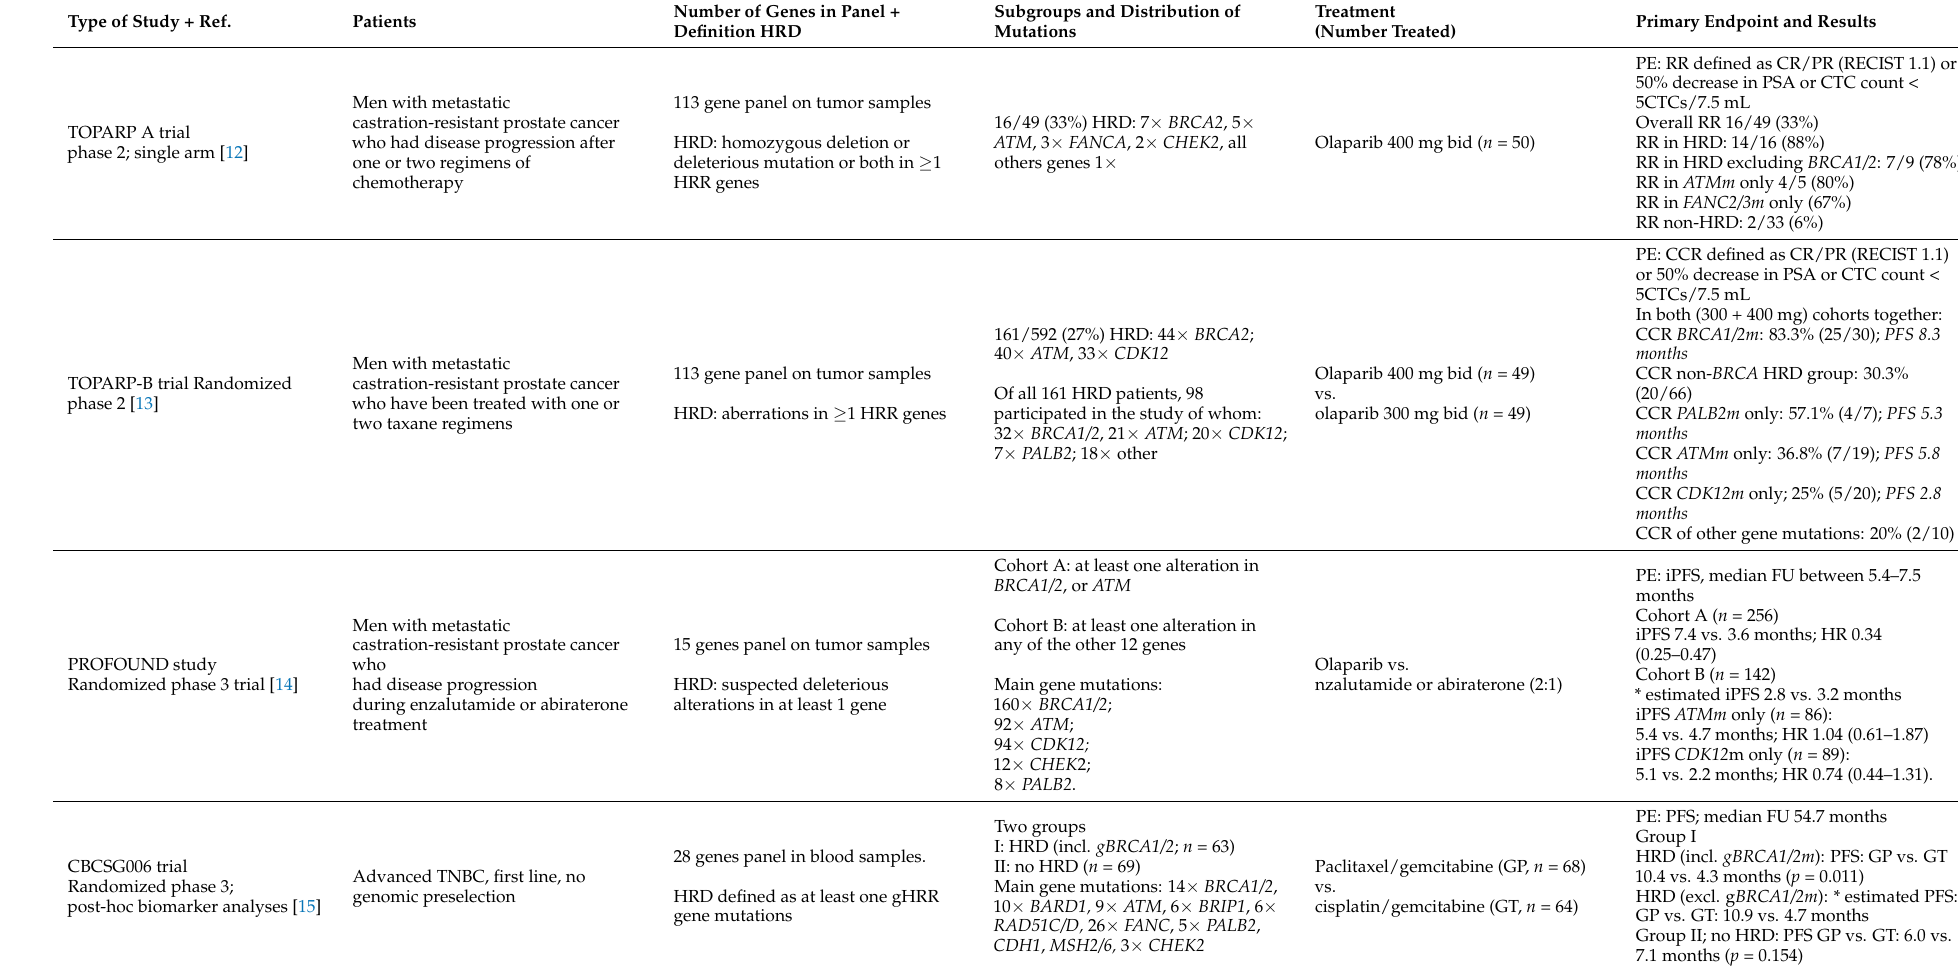
Table 1. Clinical studies investigating the predictive value of HRD measured by HR-related gene